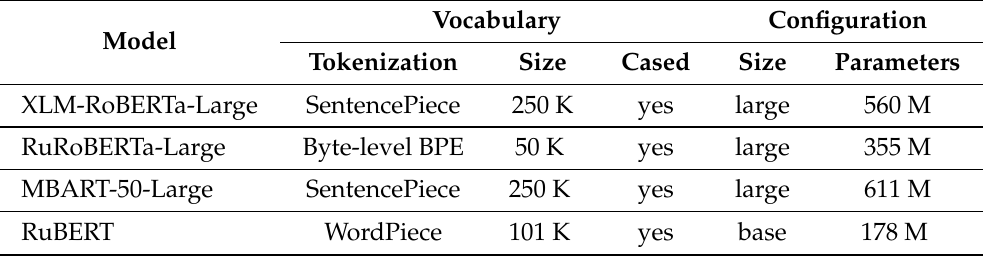
Table 2. Characteristics of selected